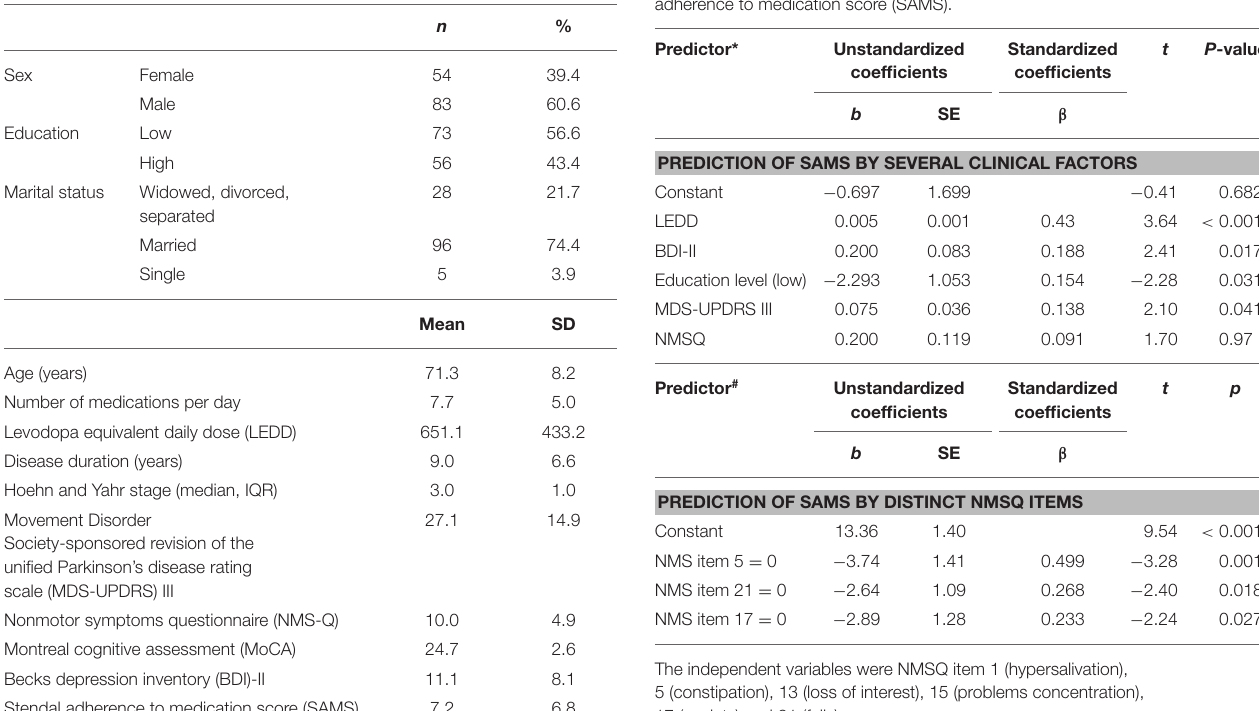
TABLE 1 | Clinical and demographic characteristics. TABLE 2 | Multiple linear regression models for the prediction of Stendal